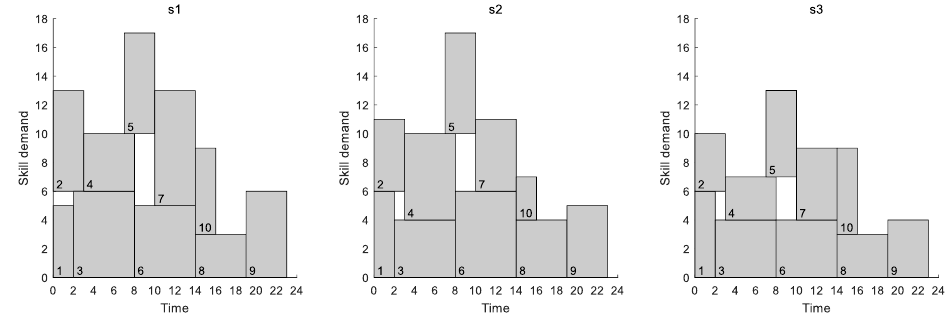
Figure 4. The scheduling of scheme 1. Table 4. Multi-skilled resource scheduling of scheme 1.